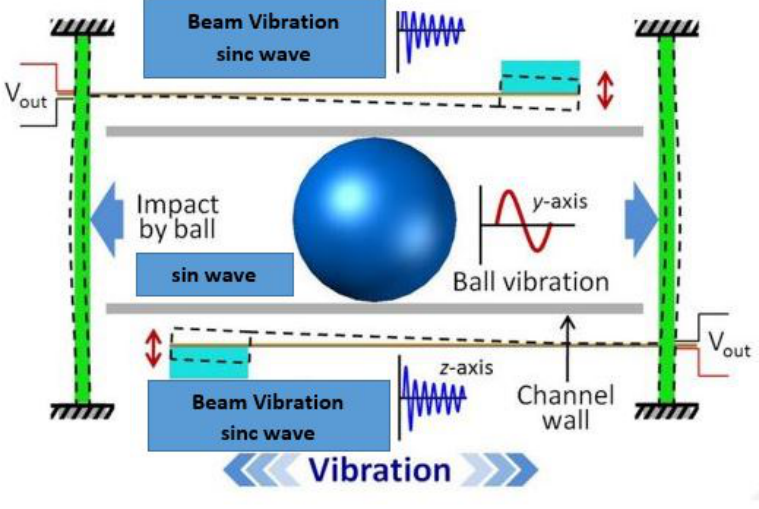
Figure 16. Schematic model of human limb-based PEH [225].